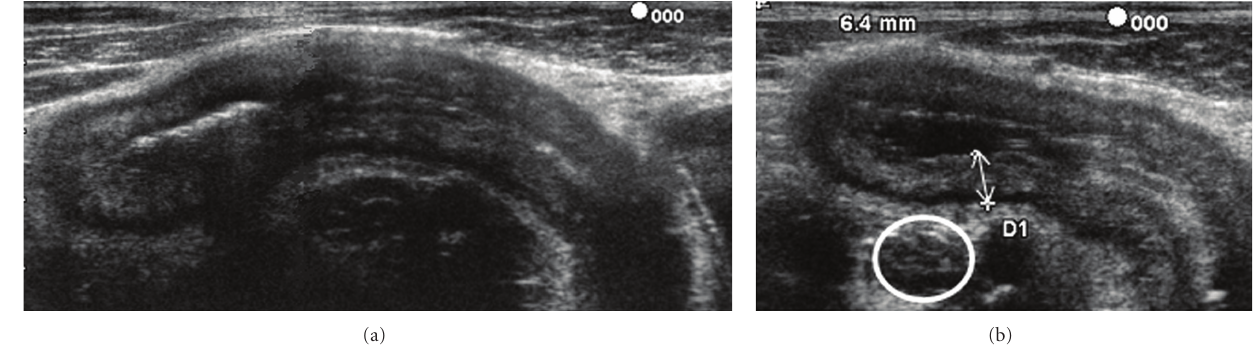
Figure 1: (a) Thickening of the ileum wall (6.4mm). Maintained laminar aspect of the intestinal wall and (b) enlarged lymph node (white circle) near the terminal